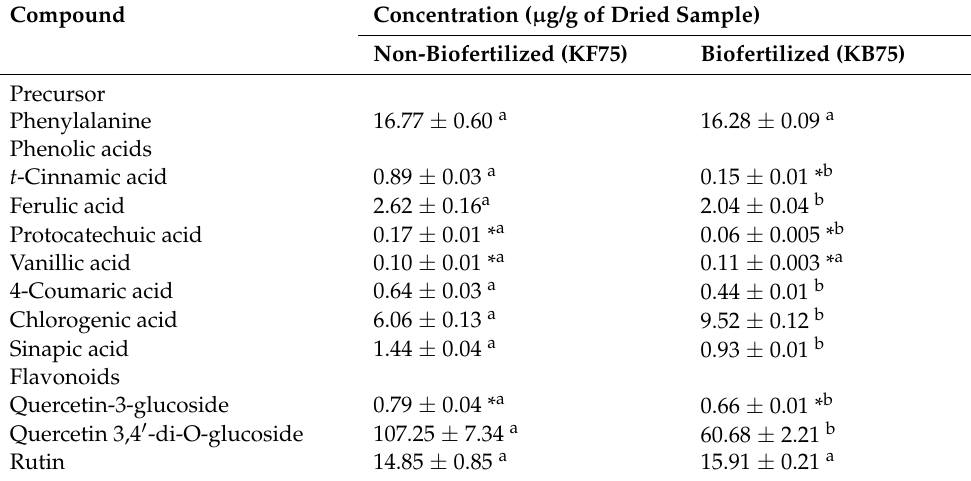
Table 6. Identification and quantification of phenolic compounds in the evaluation of the biofertilizing effect of Acinetobacter calcoaceticus UTMR2 in tomatillo fruits ( Physalis ixocarpa Brot cv. “c á scara morada”) at 75% of the recommended potassium dose